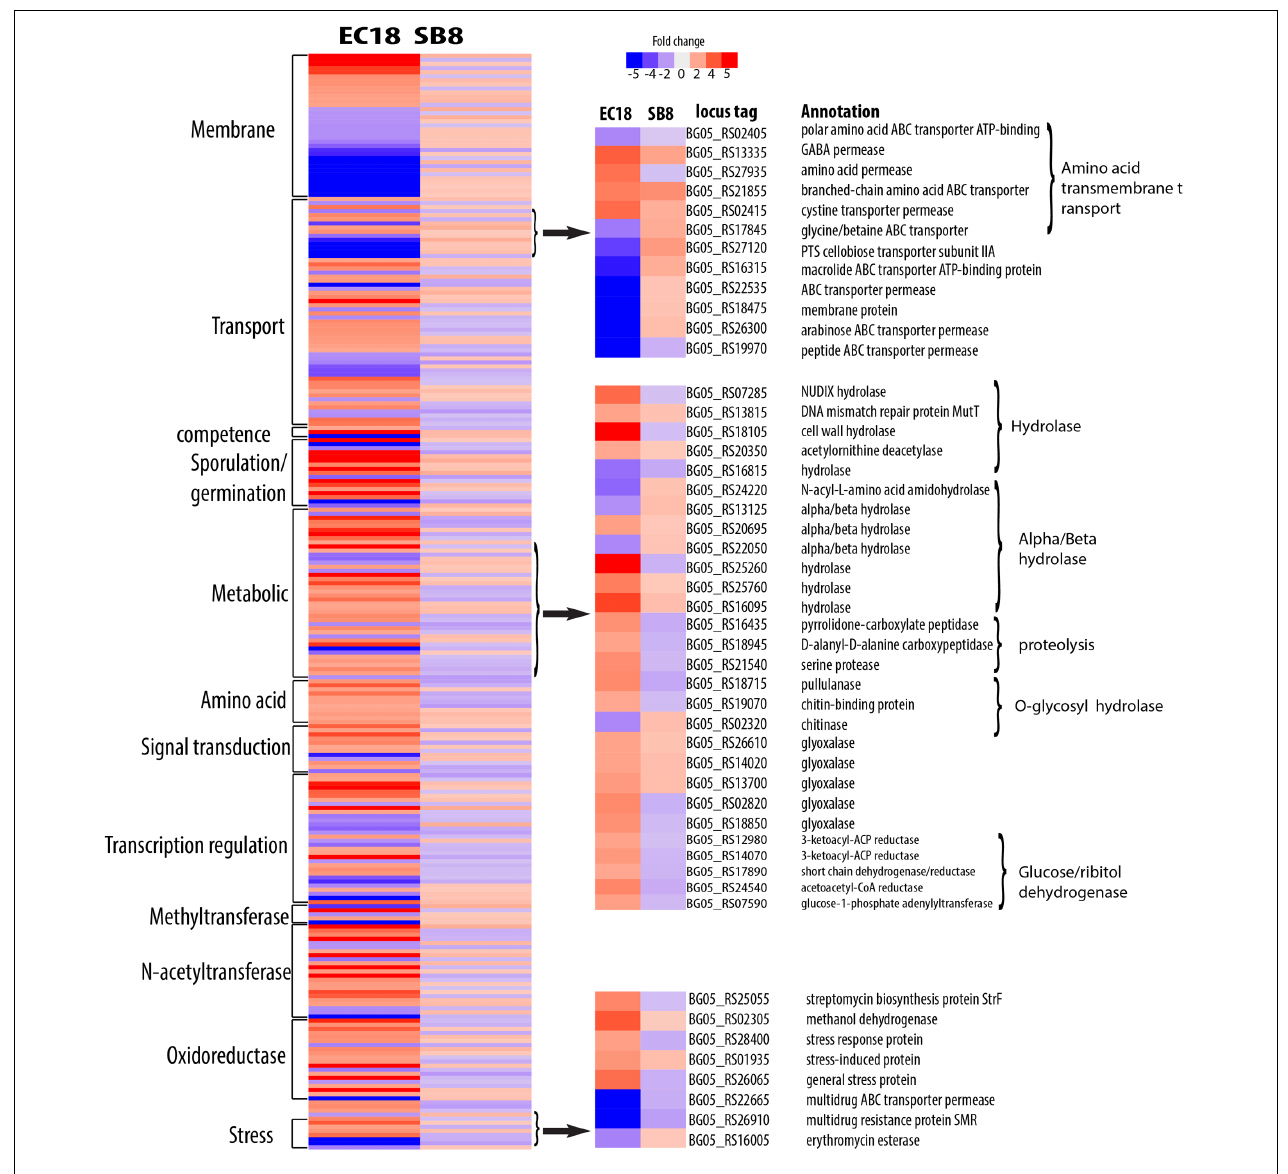
FIGURE 7 | Differentially expressed genes specifically present in endophytic strain B. mycoides EC18 in response to root exudates. Red represents significant upregulation and blue indicates significant downregulation of gene expression.